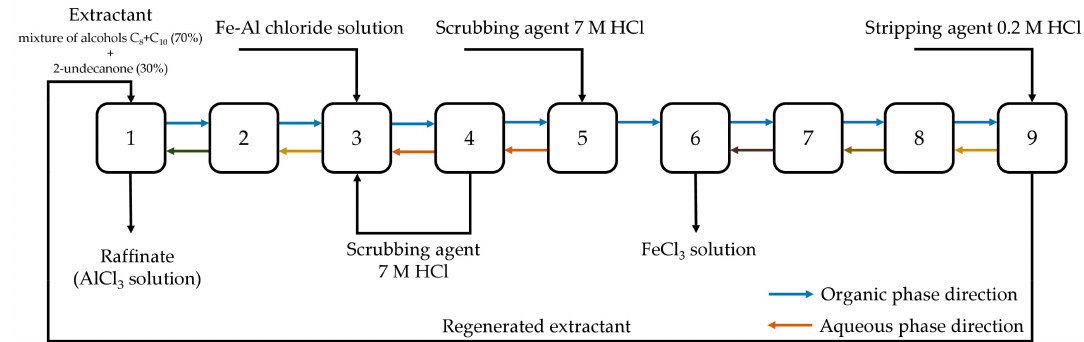
Figure 12. Scheme of the 9-stage extraction cascade for iron(III)